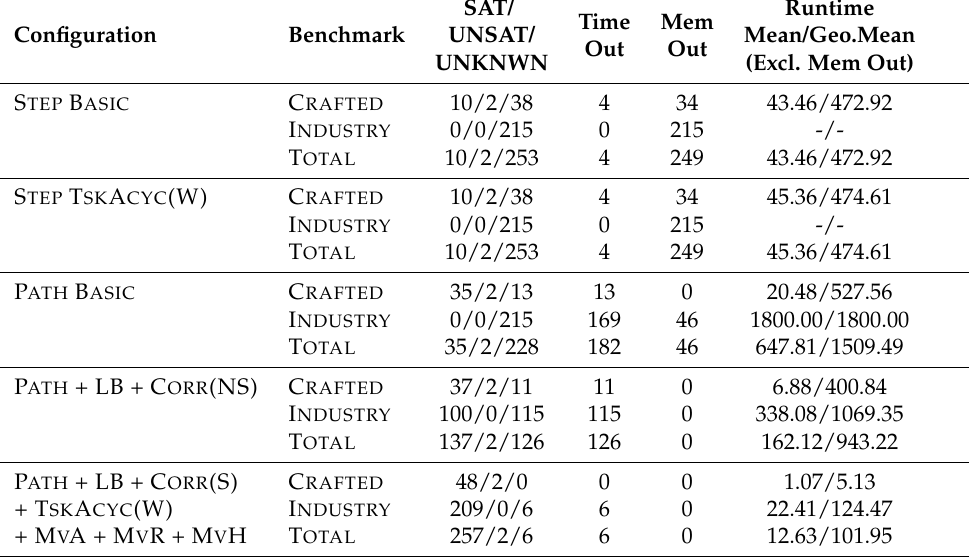
Table 4. Comparison of the step encoding and path encodings, from basic to most performant variants. Note, means and geometric means of runtimes apply to grounded instances only.